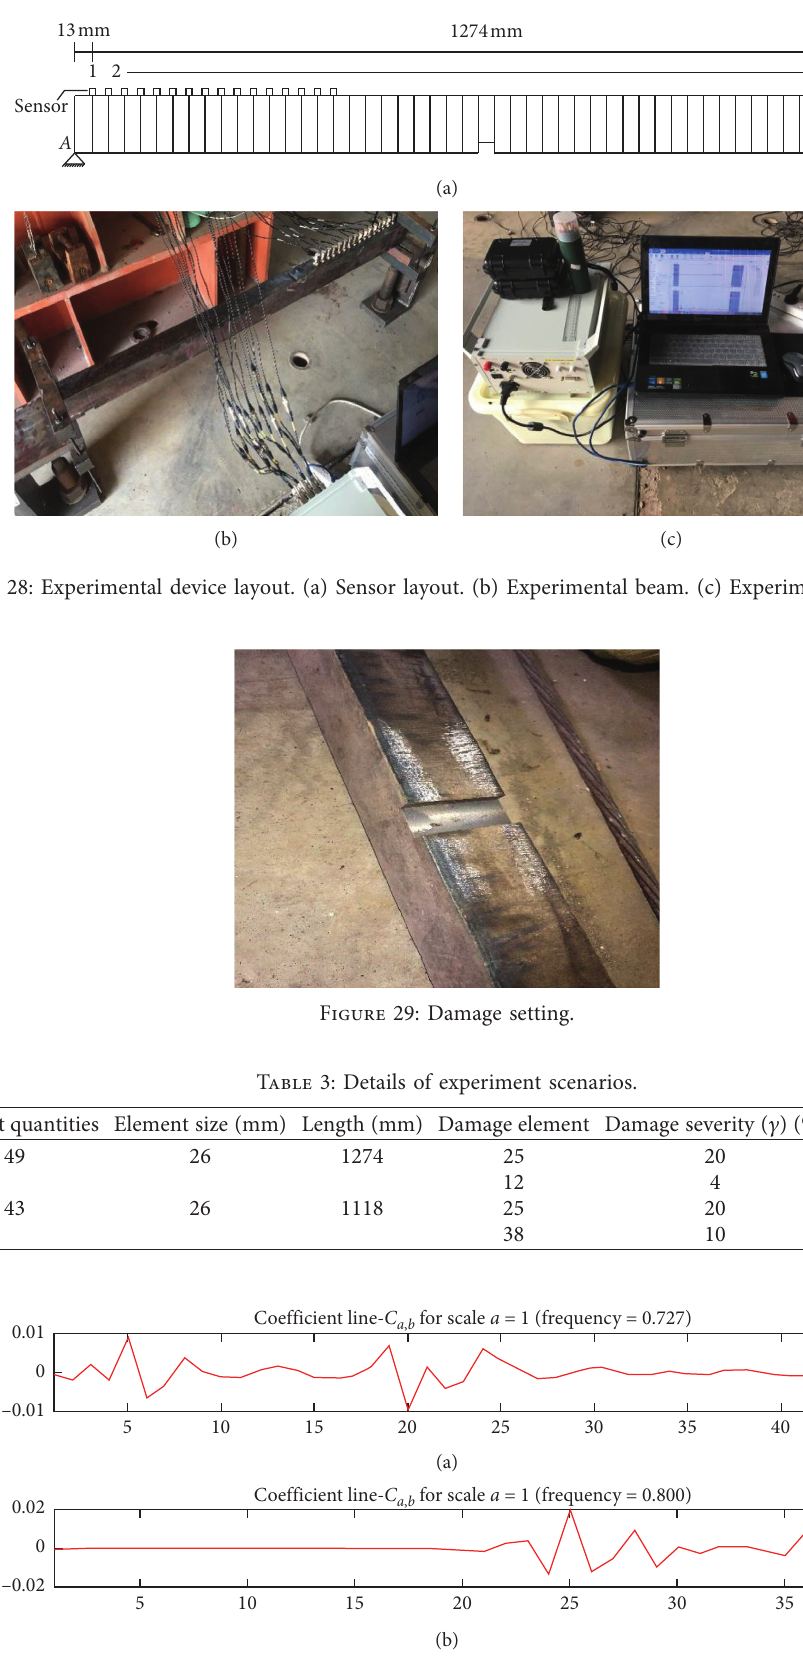
Figure 30: Experimental wavelet coefficients. (a) Wavelet coefficient of scenario 1. (b) Wavelet coefficient of scenario